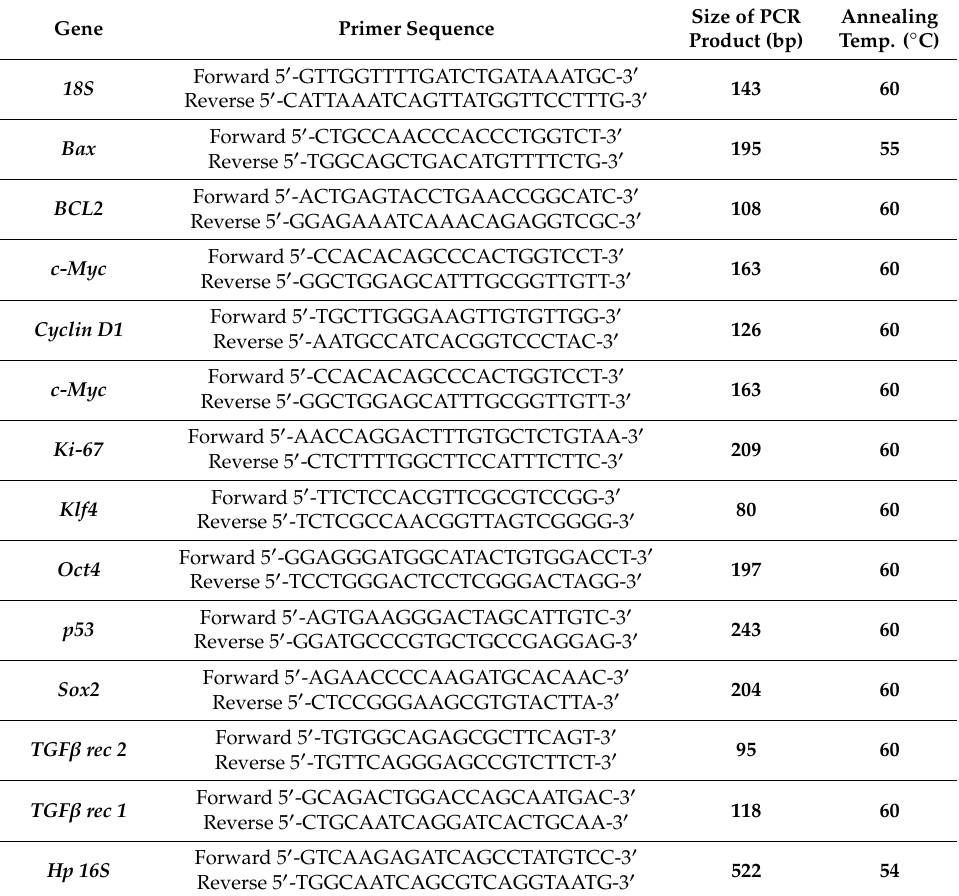
Table 1. Rat oligonucleotide primers for detection of mRNA and Hp oligonucleotide primer for detection of 16S rRNA by RT-PCR and PCR, annealing temperature and size of PCR products employed in the experimental